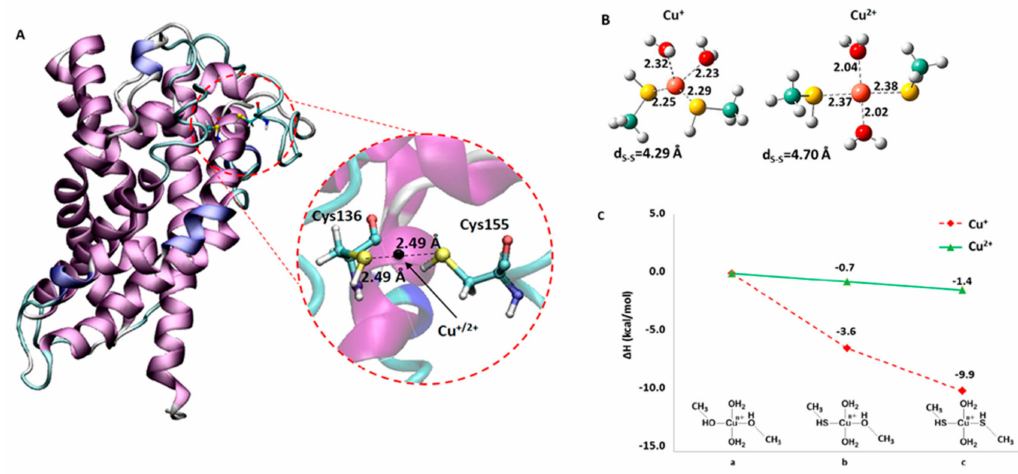
Figure 7. Computational analysis of the CAC–copper interaction. ( A ) Molecular dynamics frame (at 150 ns) of WT CAC revealing the minimum distance between C136 and C155 as evidenced in red circled region. The middle point indicates the position for copper ions. The orientation of the CAC is matrix side (up), cytosolic side (down). ( B ) B3LYP-D3 / 6-31 + G(d,p) optimized geometries for the smaller models of (Cu + (CH 3 S(H)) 2 (H 2 O) 2 ) and (Cu 2 + –(CH 3 S(H)) 2 (H 2 O) 2 ). Main geometrical parameters are reported in Å. ( C ) E ff ect of the gradual substitution of cysteine by serine (from right to left in the graph) on the binding energy ( ∆ H) for the Cu 2 + and Cu +